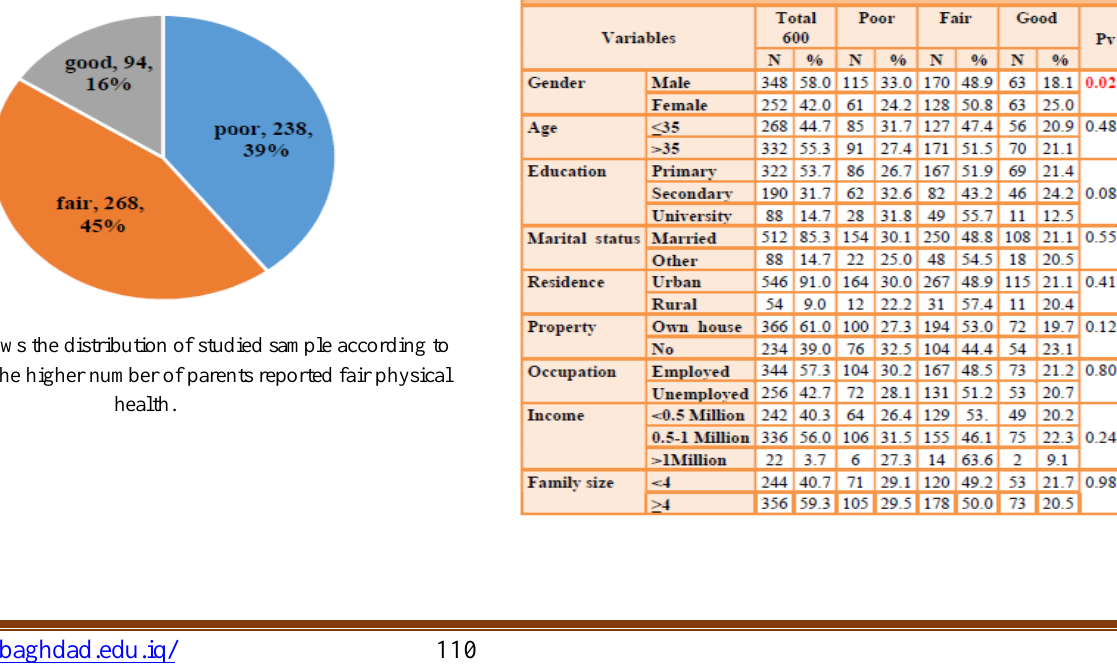
Figure 5: shows the distribution of studied sample according to environmental domain. The higher number of parents reported fair environment. Table (3) : represent the association between general QoL and different studied variables. Gender was the only variable that significantly associated with general QoL (Pv = Figure 2: shows the distribution of studied sample according to their GH (general health). The higher number of parents reported poor GH.